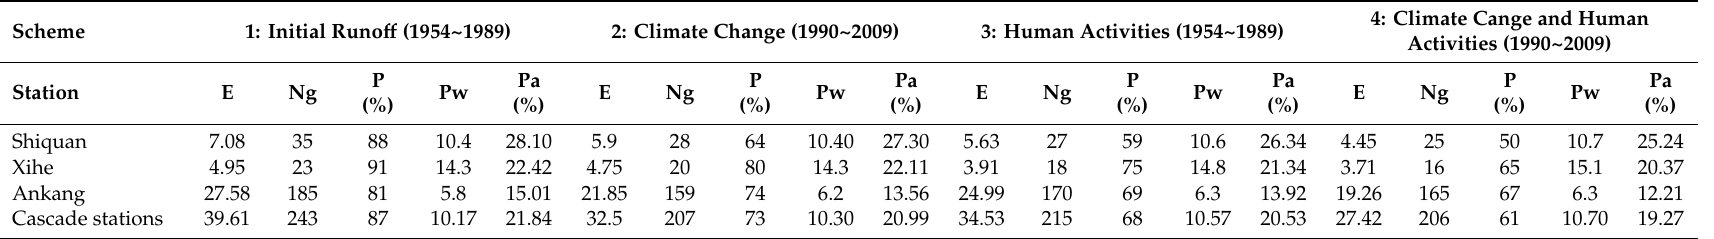
Table 4. Operating results of hydropower station under the influence of climate change and human activities (Scheme 1, Scheme 2, Scheme 3, and Scheme